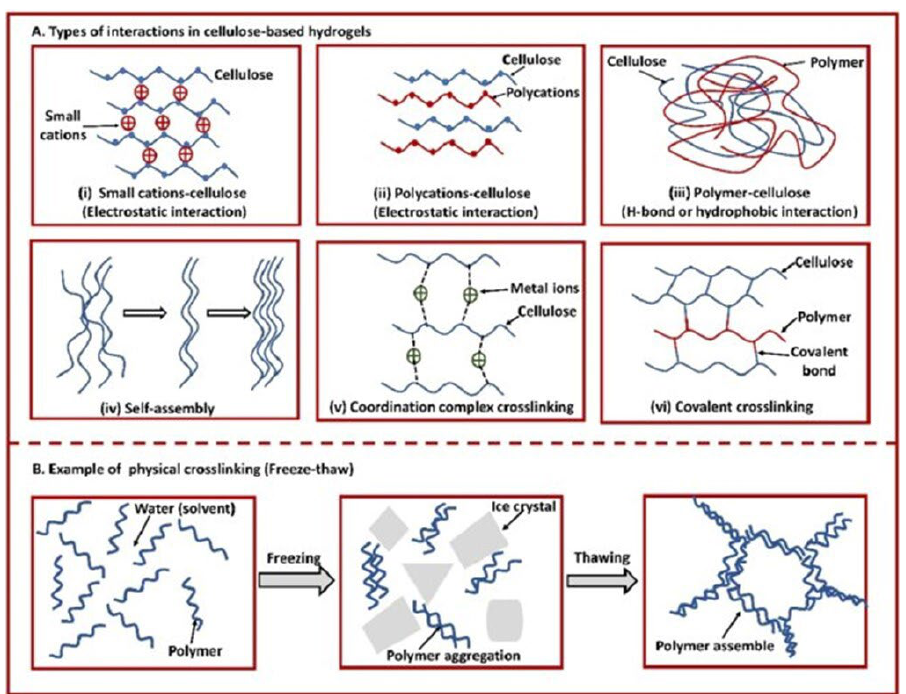
Figure 5. ( A ) Interactions in cellulose-based hydrogels in different systems. ( B ) representation of physical crosslinking, in particular freeze-thawing technique. ( A , B ) are reproduced from [58] (license CC BY 4.0).